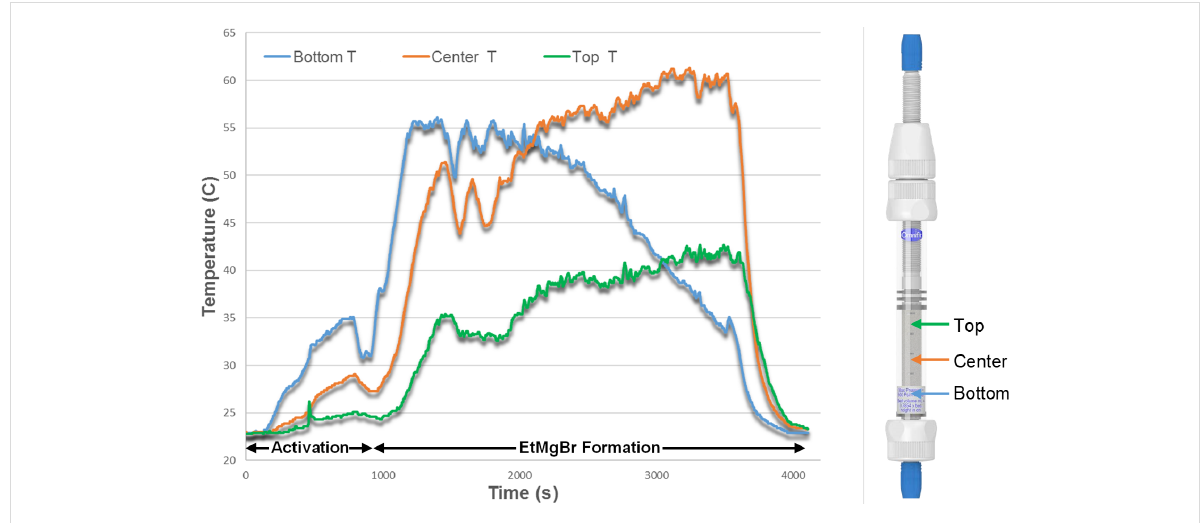
Figure 4: Temperature evolution measured with thermocouples along the column outer surface at three different